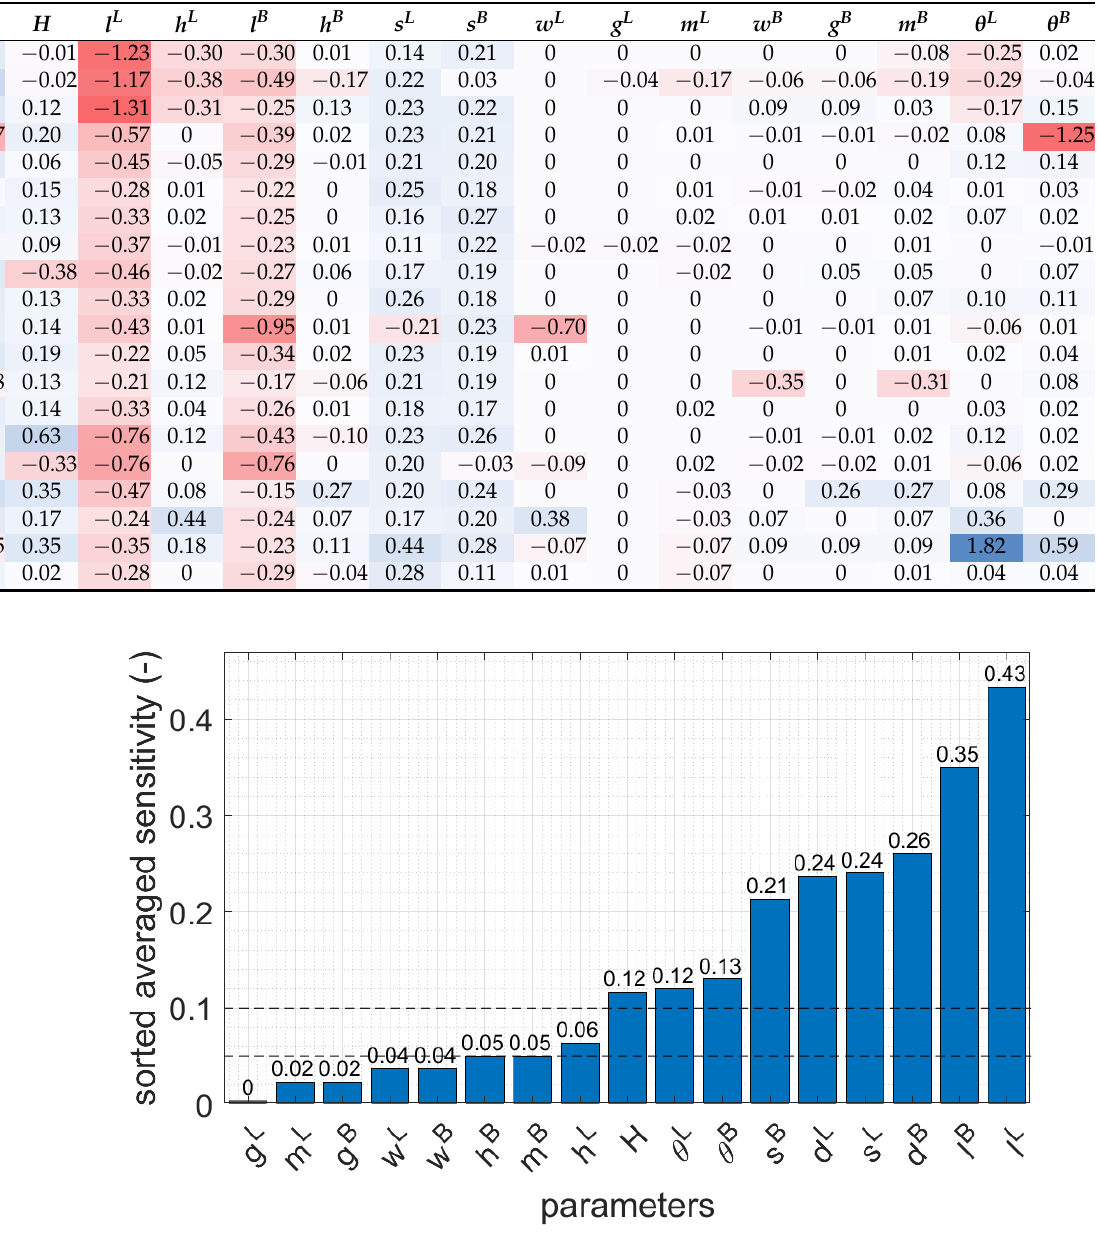
Figure 8. The averaged values of parameter sensitivities for three corrugated cardboards considered (sorted in ascending order).